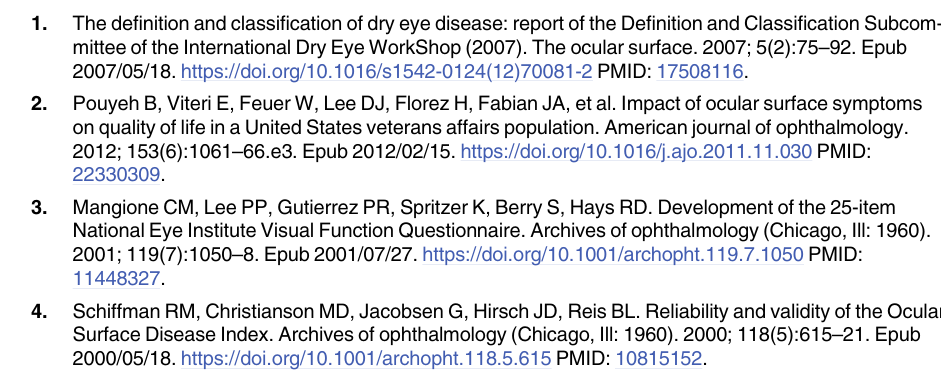
S1 Fig. Graphical results. Association of tear matrix metalloproteinase 9 immunoassay with signs and symptoms of dry eye